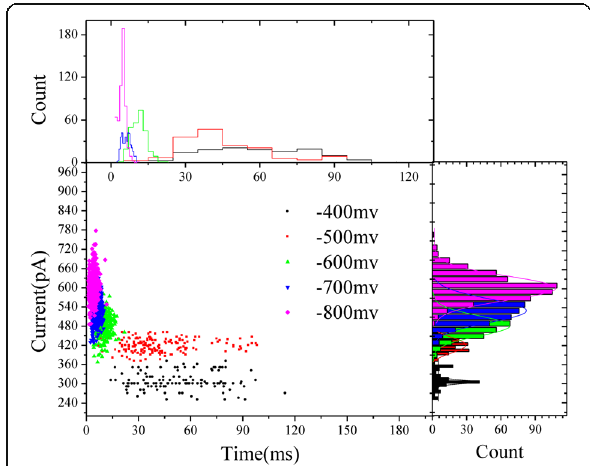
Fig. 6 Schematic representation of two dimensional scatter plots of Δ G versus events dwell time for each aggregated ABTS (cid:129) + at different voltages. The corresponding fit curves were positioned above. The insert is the translocation events of different voltages (from − 400 to − 800